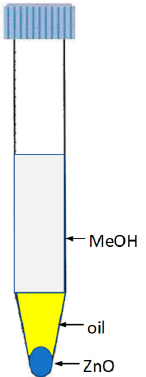
Figure 6. Schematic of the layered phases of reaction mixture after centrifugation.